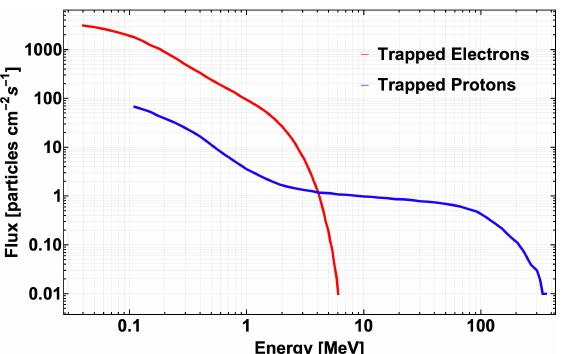
Figure 14. Energy spectra for trapped protons (in red) and electrons (in blue) at the ISS altitude and orbit.